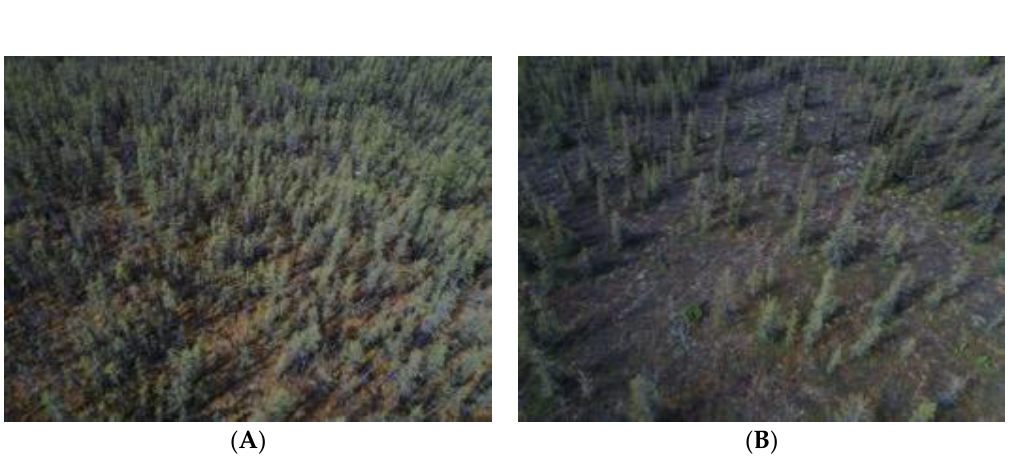
Figure 2. Aerial photographs of the high-density ( A ) and low-density ( B ) stands instrumented for in situ Normalized Difference Vegetation Index ( NDVI ). Photographs were both taken during leaf-out on 1 June 2017. Tower masts are located in the upper right corner of the photographs. Photographs: M. M. Loranty.